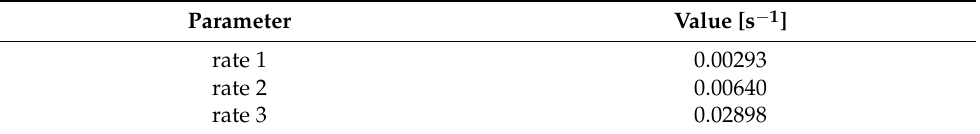
Table 1. Rates used to simulate of the sequence of swelling cycles shown in Figure